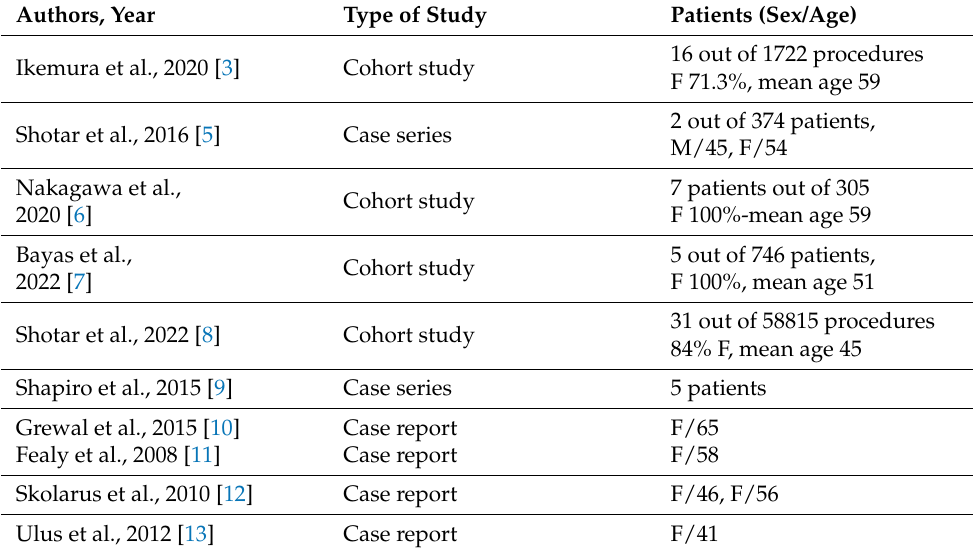
Table 2. Studies presenting NICE lesions after EVT of